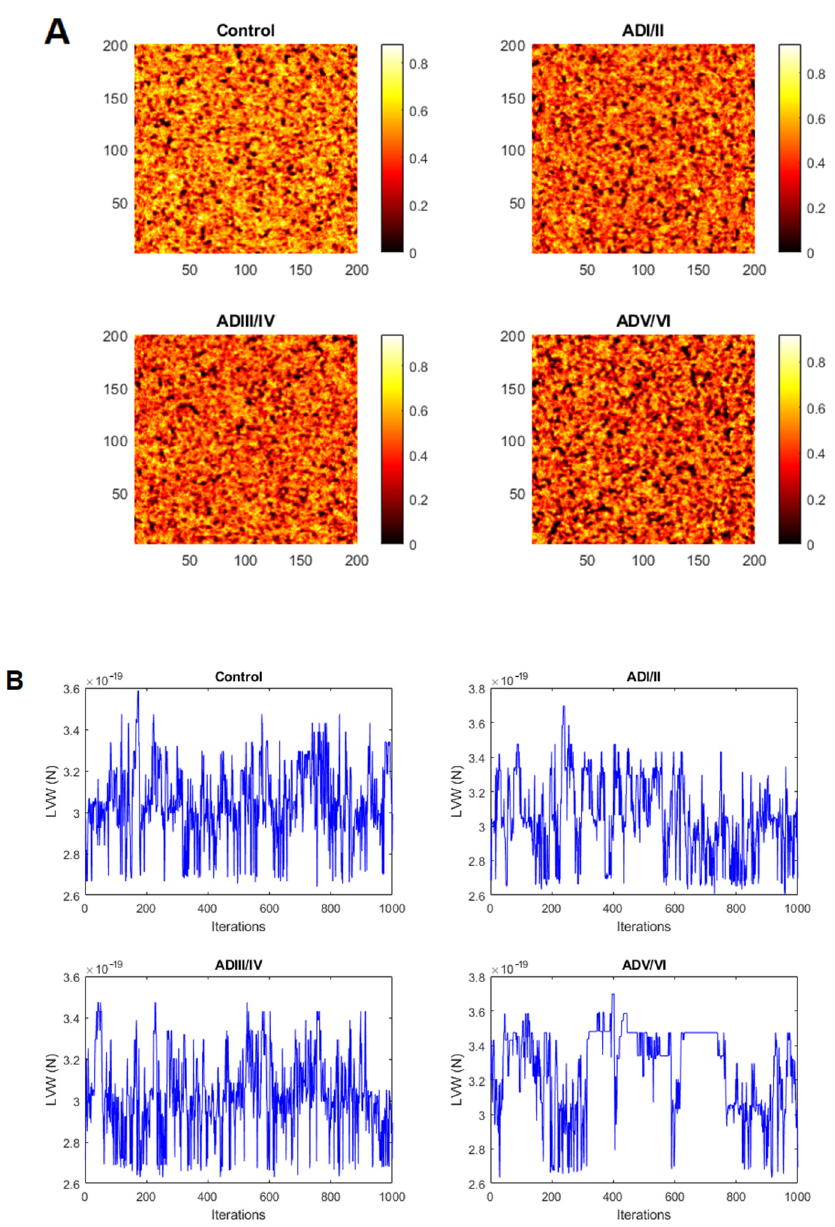
Figure 1. ( A ). Snapshots of a simulation after 1000 iterations in the four neuropathological stages. Color scale represents the mobility as the proportion of elements interchanged over the number of iterations. ( B ). Root-mean-square deviation (RMSD) for LVW forces (in N) corresponding to simulations displayed in panel A.